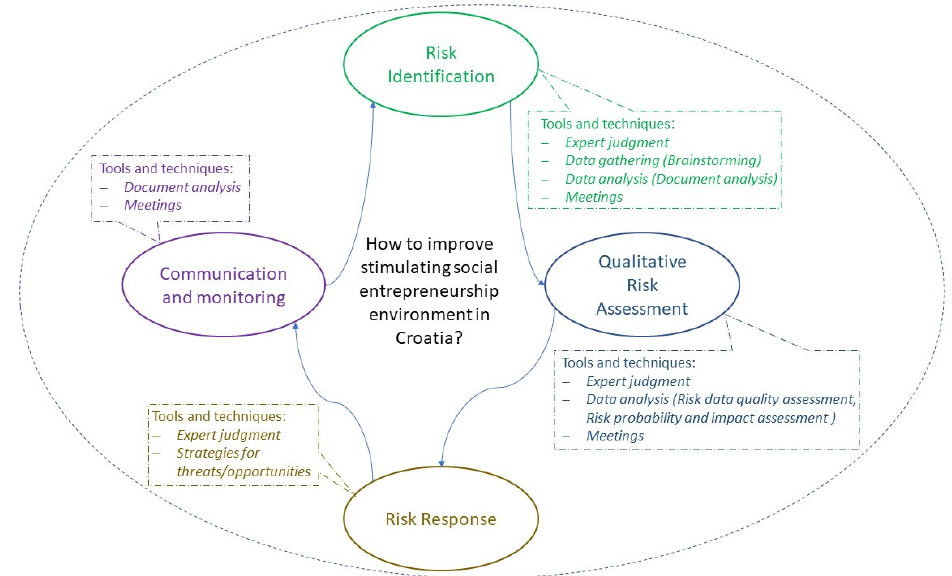
Figure 4. Framework for risk management in the improvement of stimulating social entrepreneurship environment in Croatia. Source: Authors.